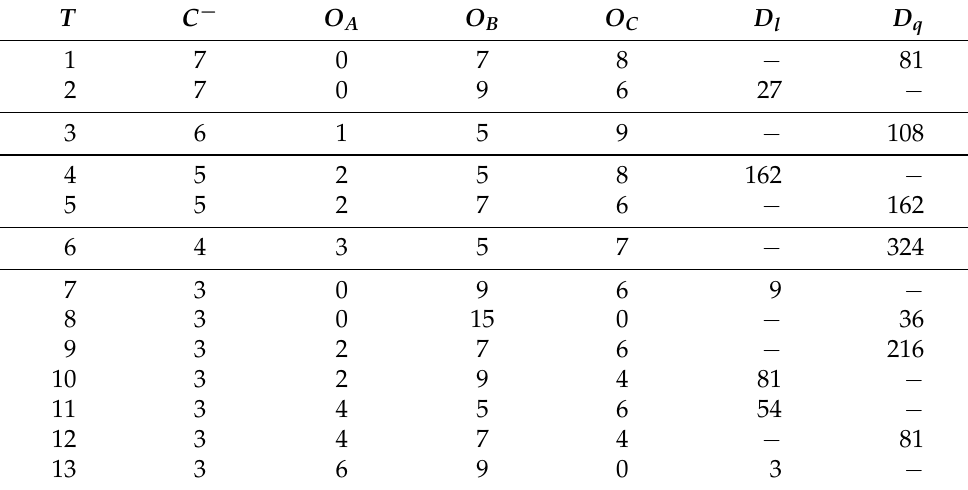
Table 3. Classification of doilies living in W ( 5,2 ) . Column one ( T ) shows the type, column two ( C − ) the number of negative lines in a doily of the given type, columns three to five ( O A to O C ) indicate the number of observables of corresponding types and columns six ( D l ) and seven ( D q ) yield, respectively, the number of ‘linear’ and ‘quadratic’ doilies of a given type. T C − O A O B O